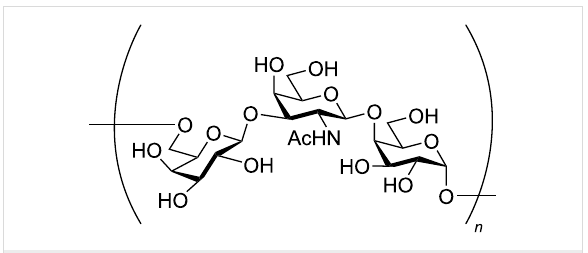
Figure 1: Structure of the repeating unit of the lipopolysaccharide of Providencia stuartii O49